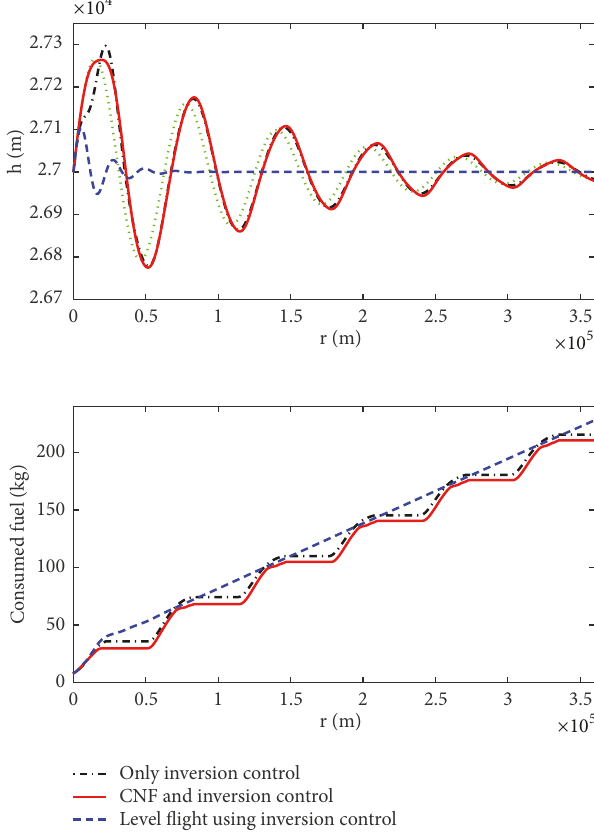
Figure 11: Consumed fuel in relation to level flight and periodic cruise between with CNF and without